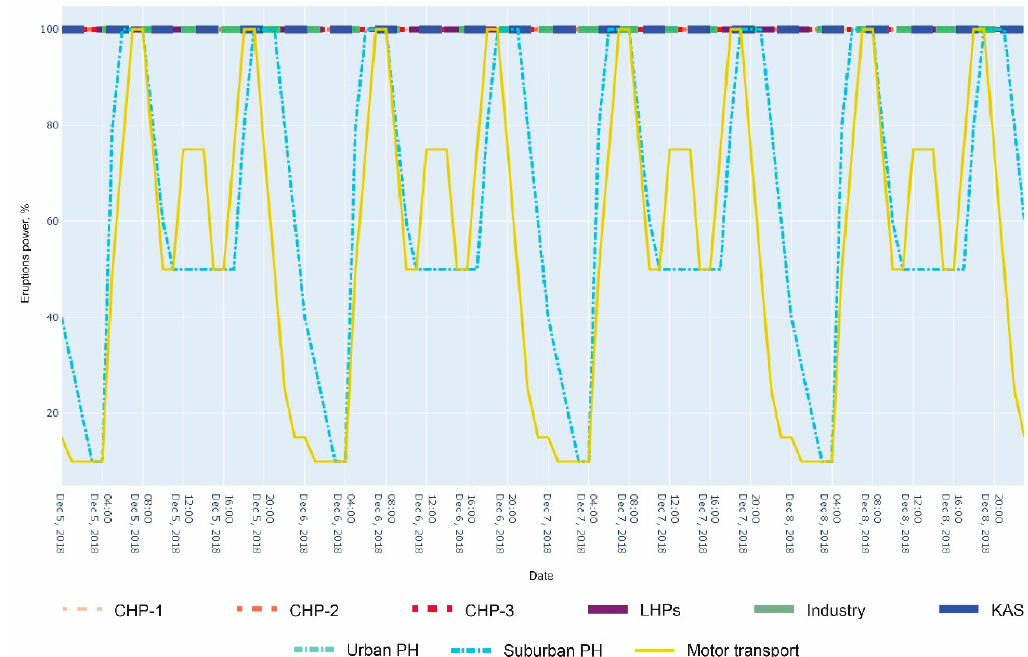
Figure 7. Emission sources time profiles designed to account for the intensity from different groups of sources.